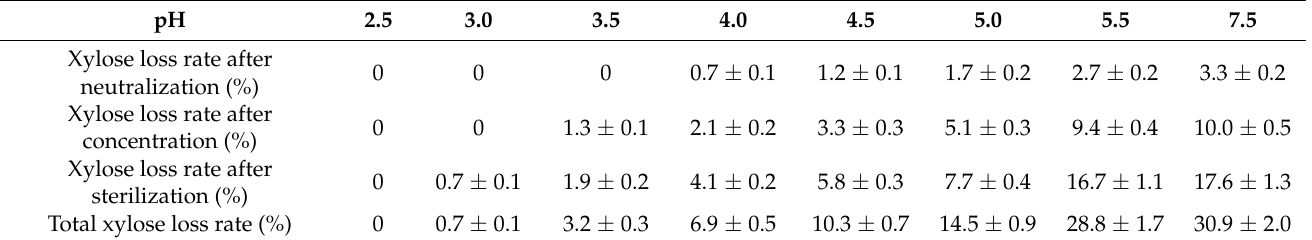
Table 1. Effect of different pH values on xylose loss during concentration and sterilization.